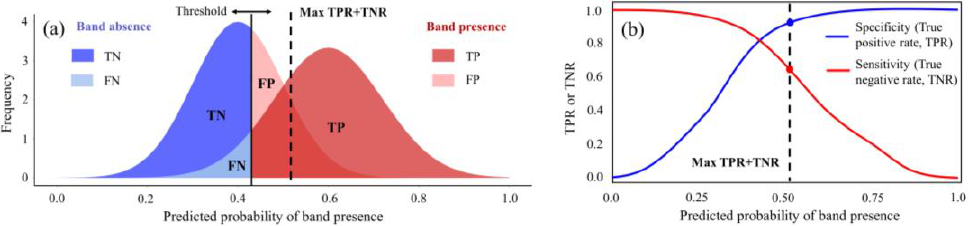
Figure 4. Illustration of max TPR + TNR threshold for binary classification. ( a ) Frequency of band presence-absence distribution [77]; ( b ) sensitivity-specificity curve.